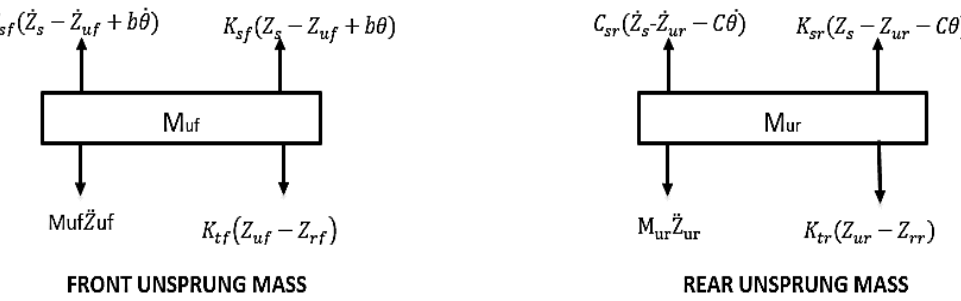
Figure 7. Free body diagrams for front and rear unsprung mass